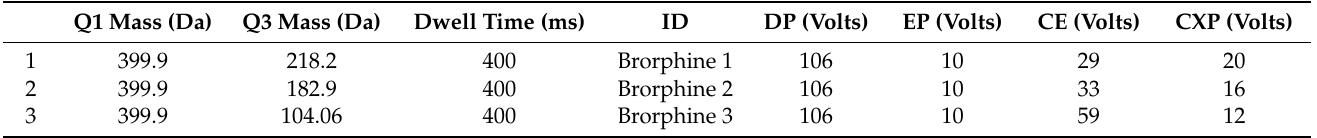
Table 1. MS parameters for the identification and quantitation of brorphine. The ion in bold (218.2) was used for